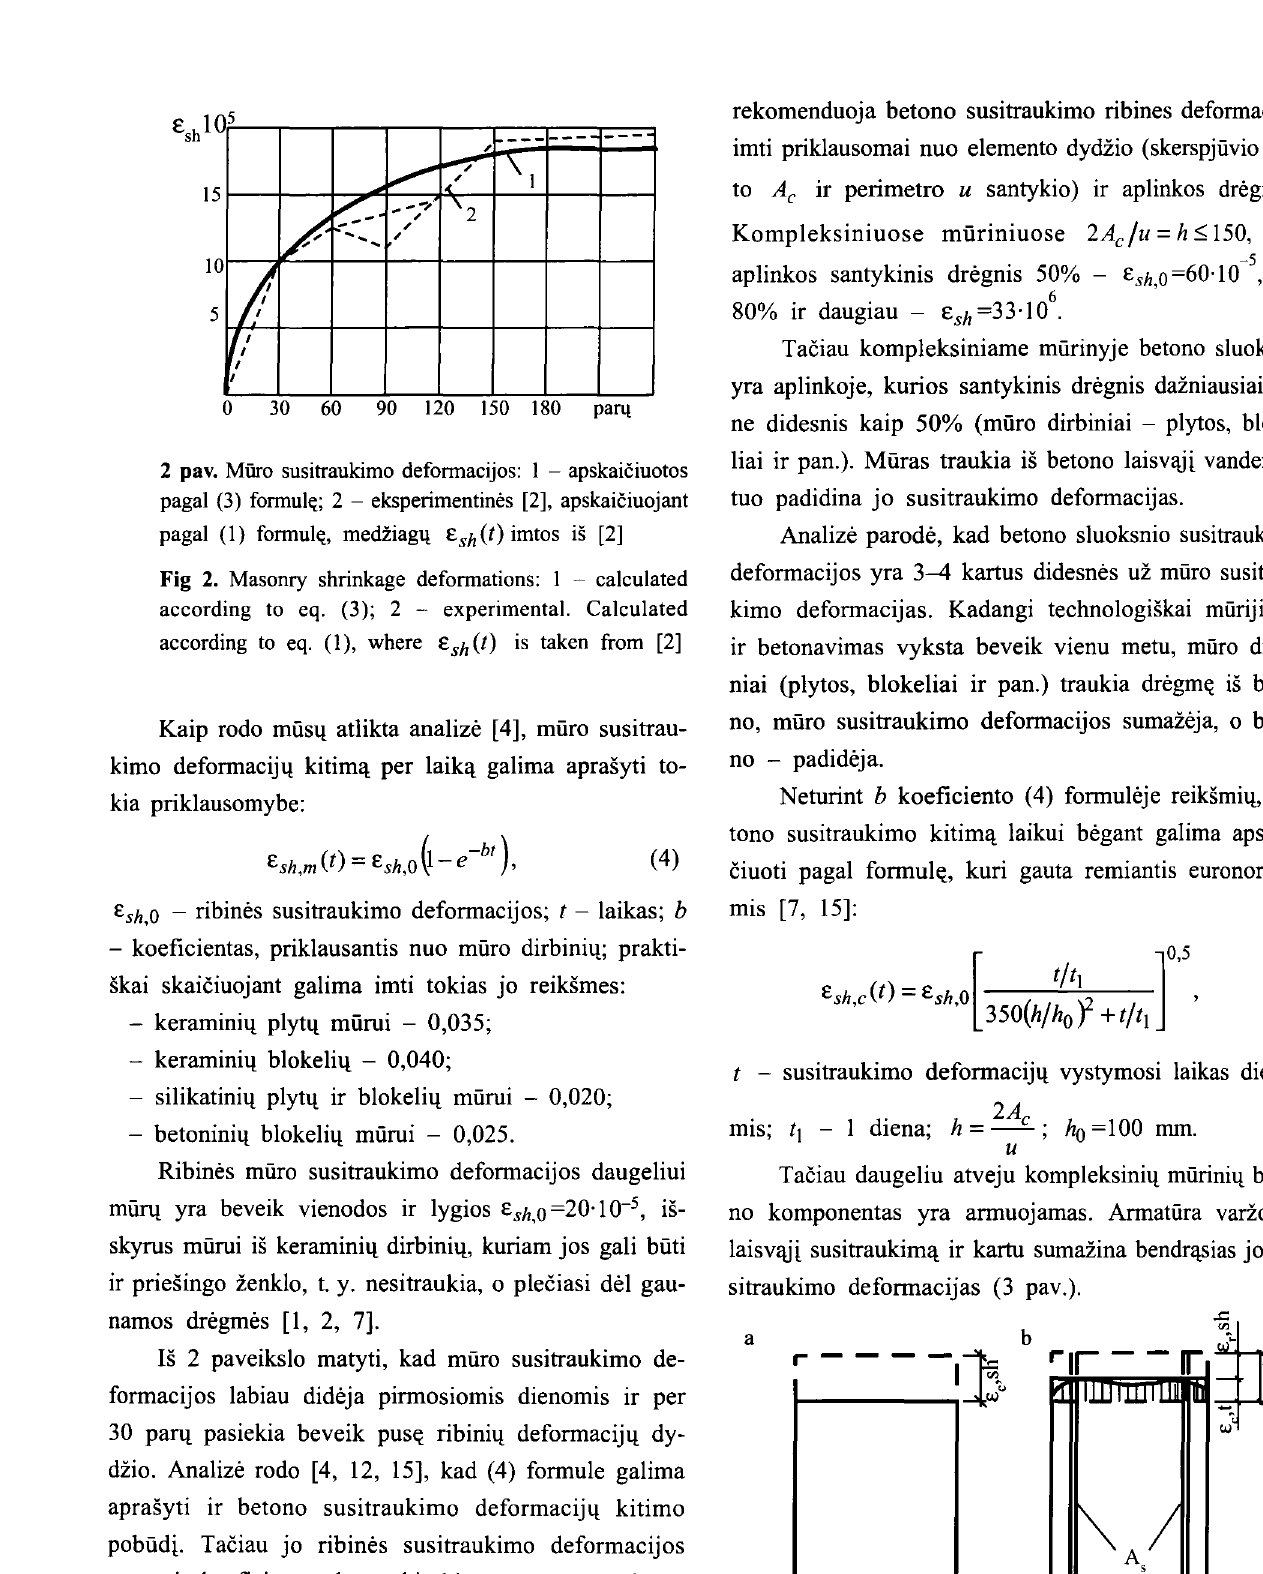
pagqsti. TaCiau, kaip rodo tyrimai ir sukauptq duome nq analize [ 1 0-12], ribines betono susitraukimo defor macijos ir jq pobiidis taip pat priklauso nuo daugelio veiksniq. Todel b koeficiento (4) formuleje nustatymas turi biiti pagristas eksperimentais. Euronormos [ 11, 17]